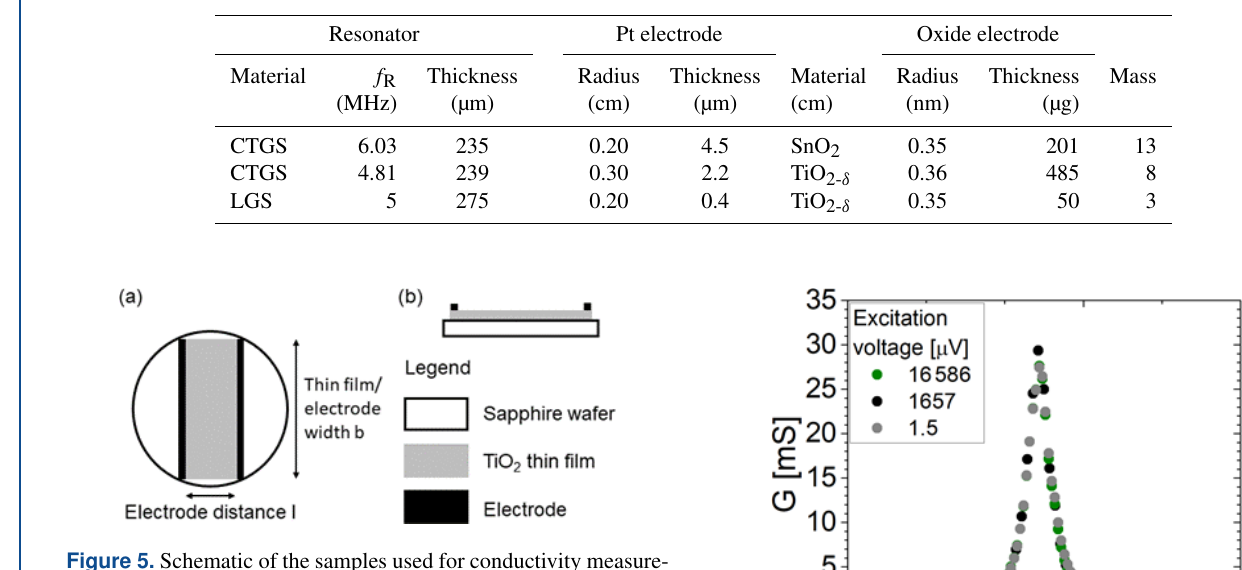
Table 1. Resonator properties.